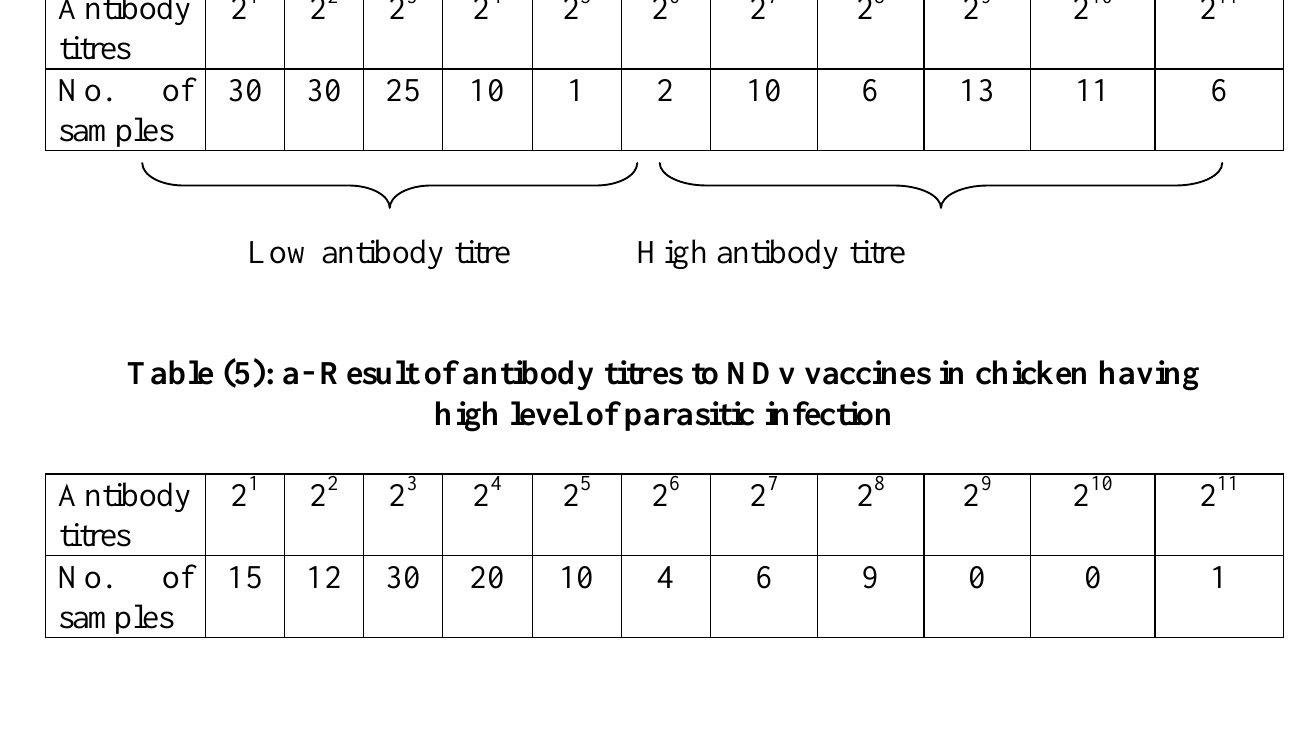
Table (4): Results of antibody titre to NDv vaccine in non infected birds, using the HI- Test. Antibody